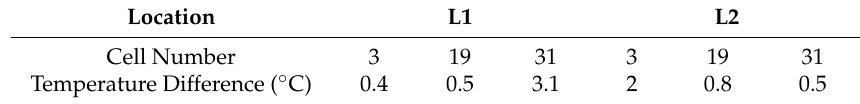
Table 5. Temperature differences between the experimental and numerical results.